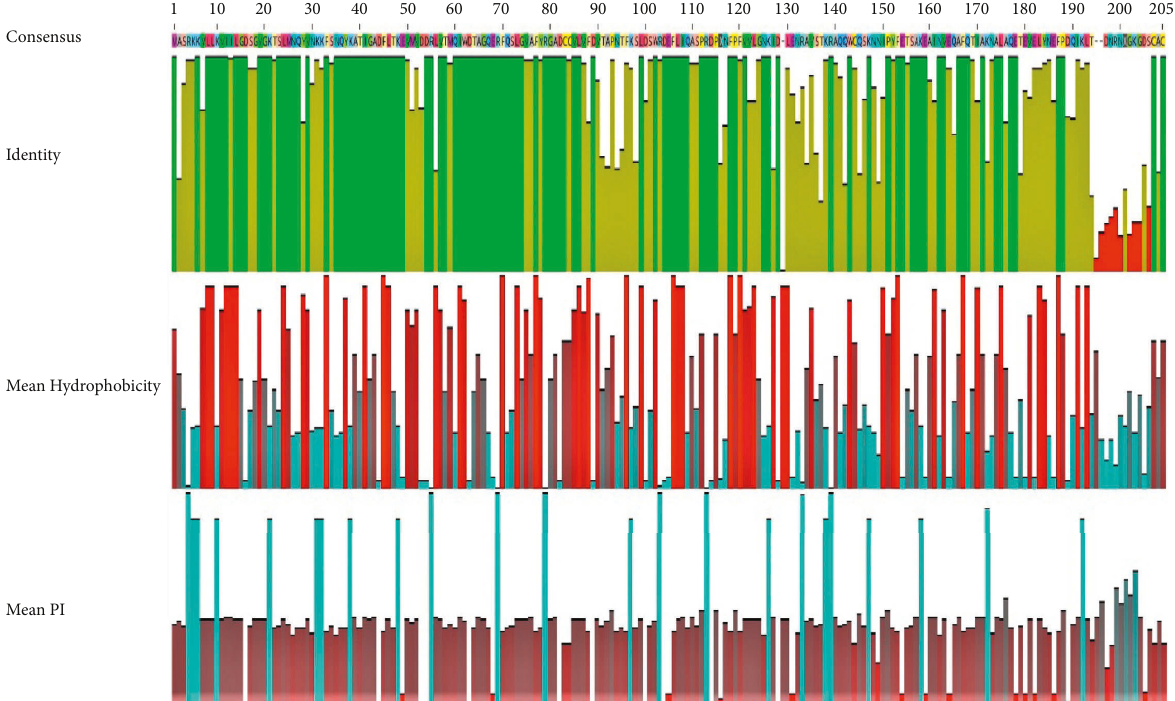
Figure 2: Mean hydrophobicity, isoelectric point, and identity of 100 Rab7 sequences after multiple sequence alignment.